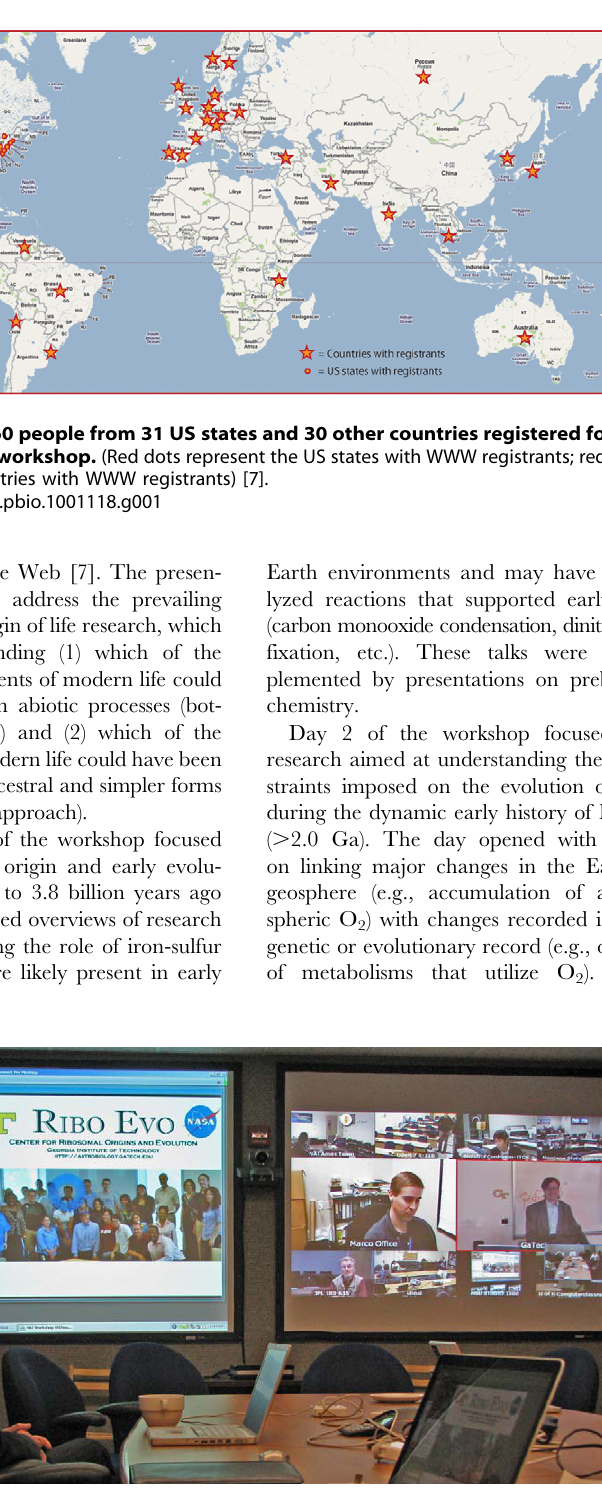
Figure 2. Dual screens in a videoconferencing room at the NASA Astrobiology Institute. On the left screen is the online meeting software showing speaker slides, video, and chat windows. On the right screen is a mosaic of other videoconferencing rooms connected for the workshop. Over the course of the November 2010 workshop connections were made to 21 different videoconferencing sites at US and international institutions. The video feeds were integrated with Adobe Connect and broadcast live to participants around the world, who could ask questions through an integrated chat window. In addition, presentations were recorded and have been archived and made available to the public via the internet